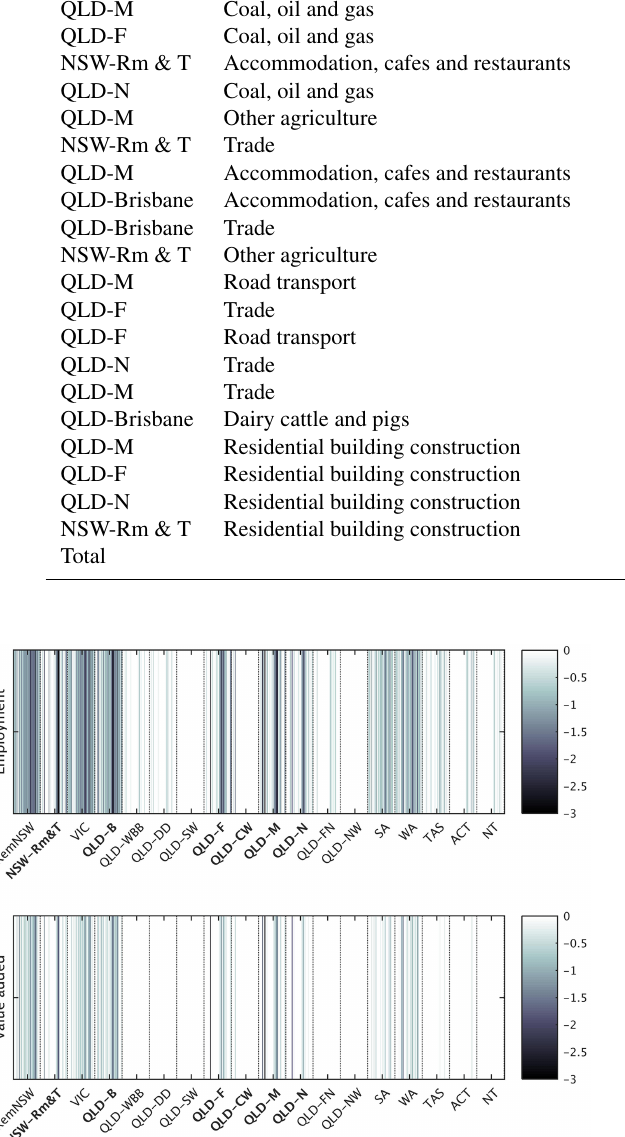
Figure 3. Spillover in employment and value-added losses result- ing from a tropical cyclone, by state and sector. The magnitude of employment and value-added losses is expressed as log 10 | (cid:49)Q | and visualised as lines on a grey scale. Each line represents one of the 34 industries in each region, in the sequence order listed in Sect. S1. Region acronyms as in Fig. 1; bold regions are those directly af- fected. See also Sect.